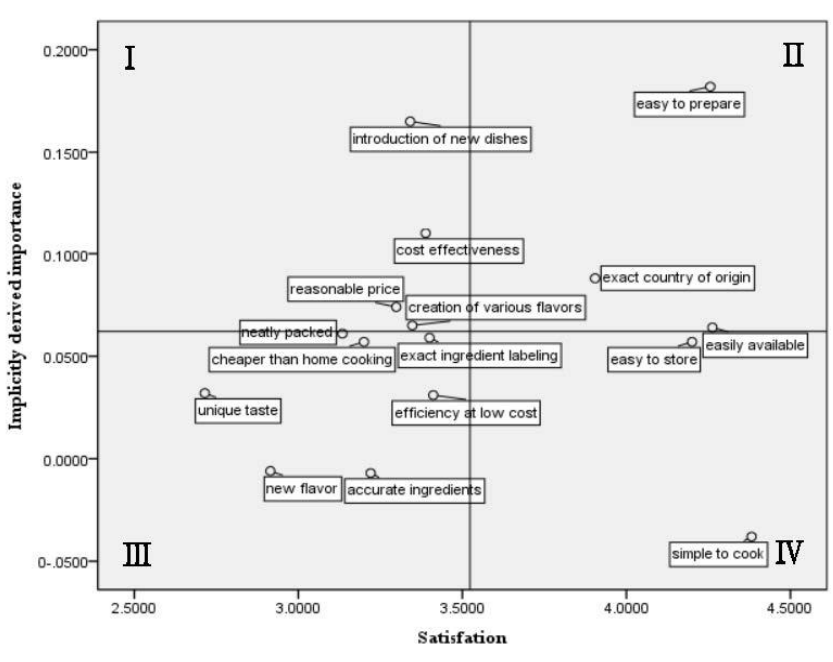
Figure 1. Matrix results of an importance–performance analysis of home meal replacement attrib- utes.